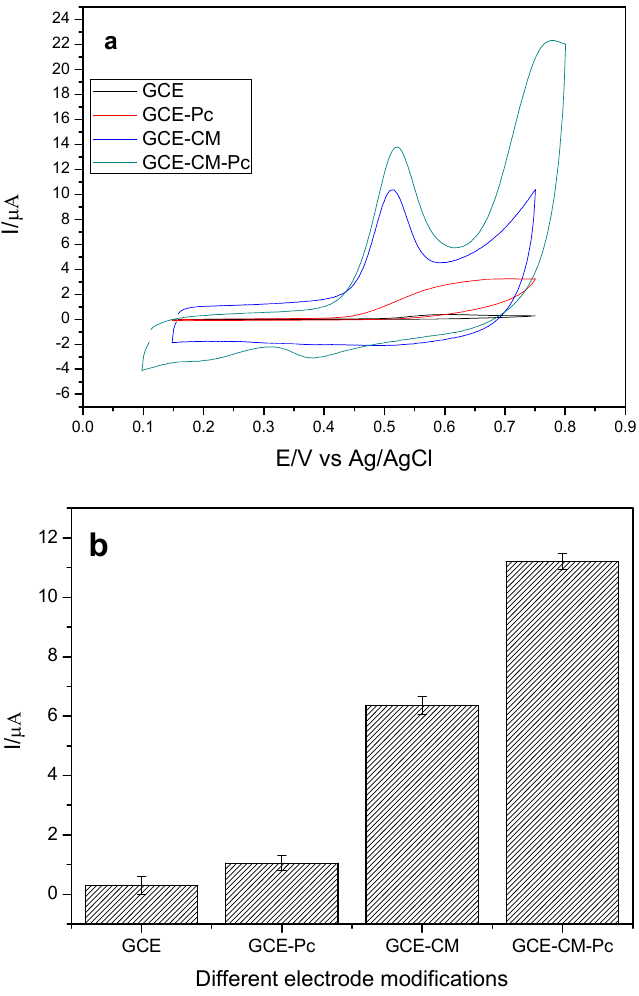
Figure 2. ( a ) Evaluation of the influence of the modifiers in the presence of ethinyl estradiol 175 µ mol L −1 , buffer solution Phosphate 0.10 mol L −1 , pH 7.0. Cyclic voltammetry, scan rate of 0.01 V s −1 . ( b ) Comparison of current variations generated for each modification made.